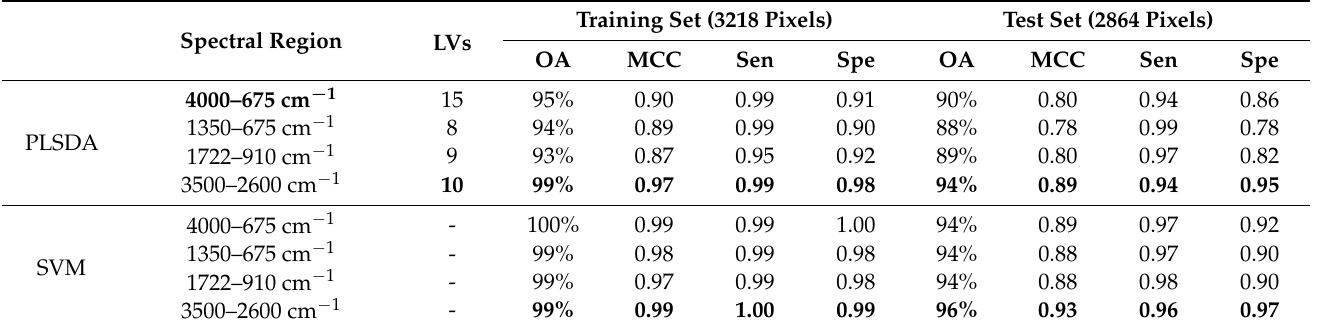
Table 4. Model performance to compare classifiers (PLSDA against SVM) and different spectral regions for samples deposited on stainless steel.